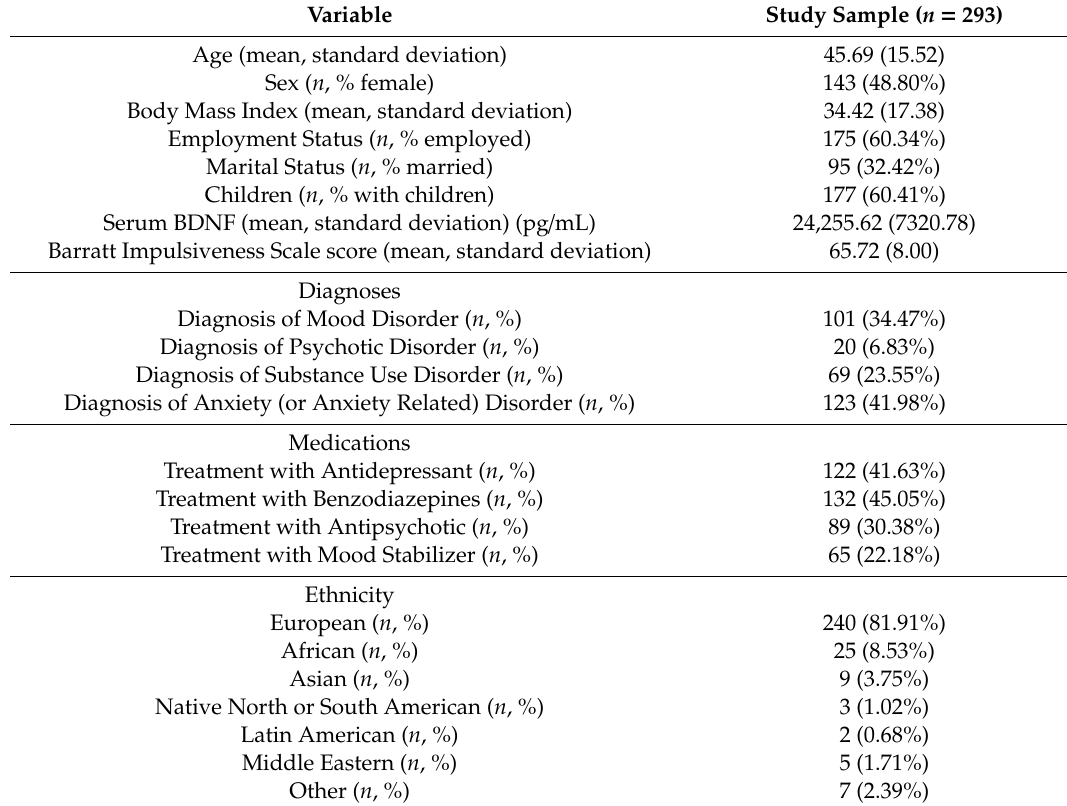
Table 1. Characteristics of study population.